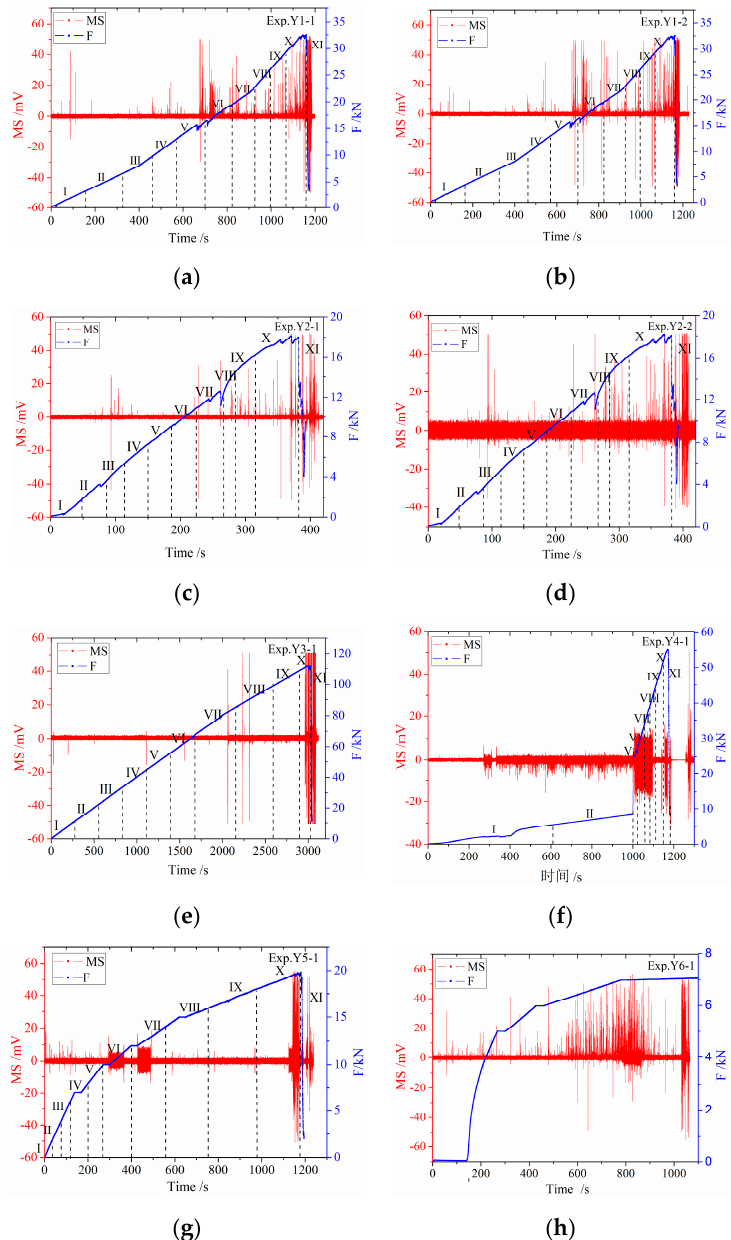
Figure 5. The relationship of MS and loading force (F). ( a ) Exp.Y1-1; ( b ) Exp.Y1-2; ( c ) Exp.Y2-1; ( d ) Exp.Y2-2; ( e ) Exp.Y3-1; ( f ) Exp.Y4-1; ( g ) Exp.Y5-1 and ( h ) Exp.Y6-1. Note: Exp.Y1-1 represents the 1#